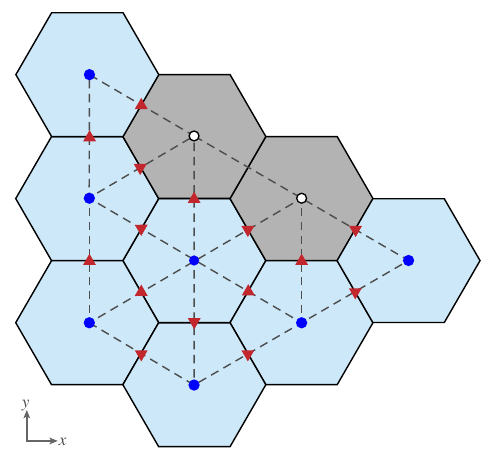
Figure 2. Correspondence between MPAS and Albany meshes and the application of boundary conditions for the first-order velocity solver. Solid black lines are cells on the Voronoi mesh and dashed gray lines are triangles on the Delaunay triangulation. Light blue Voronoi cells contain dynamic ice and gray cells do not. Dark blue circles are Albany triangle nodes that use variable values di- rectly from the colocated MPAS cell centers. White circles are extended node locations that receive variable values as described in the text based on whether they are terrestrial, floating marine, or grounded marine locations. Red triangles indicate Voronoi cell edges on which velocities ( u n ) are required for